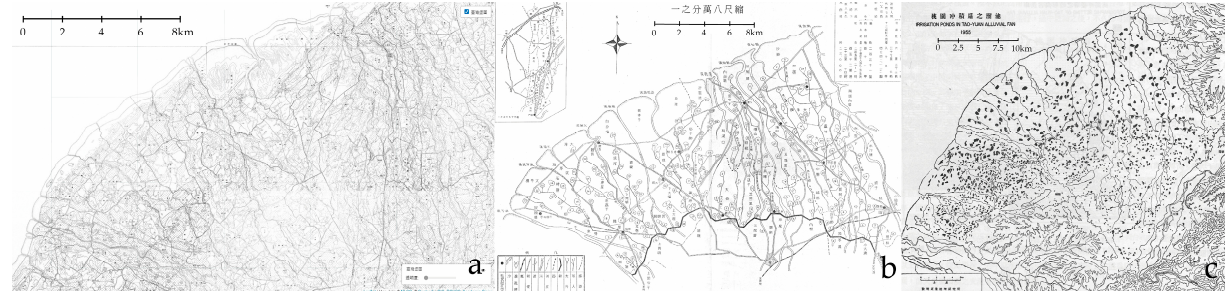
Figure 4. Farm pond system developed ( a ) in 1904 [44], adapted from Center for GIS, ( b ) upon the completion of the Taoyuan Canal in 1924 [45], adapted from Taoyuan Irrigation Association with a scale representing the original Chinese note of 1/80,000 on top, and ( c ) upon the completion of the Shimen Reservoir in 1964 [46], adapted from Chen, C.S.